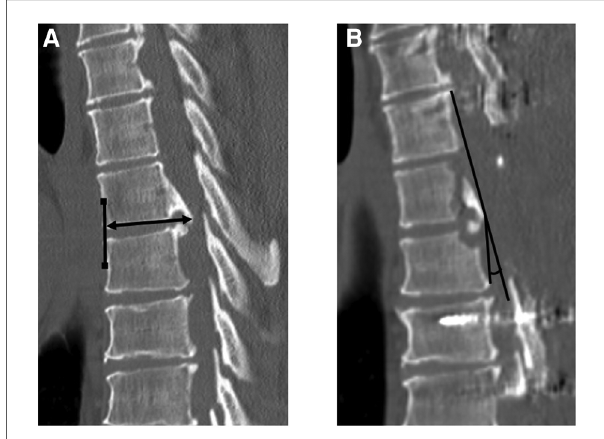
FIGURE 4 De fi nition of measurements of ossi fi cation of the posterior longitudinal